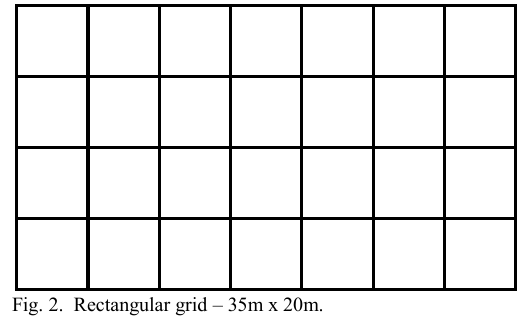
Fig. 2. Rectangular grid – 35m x 20m.